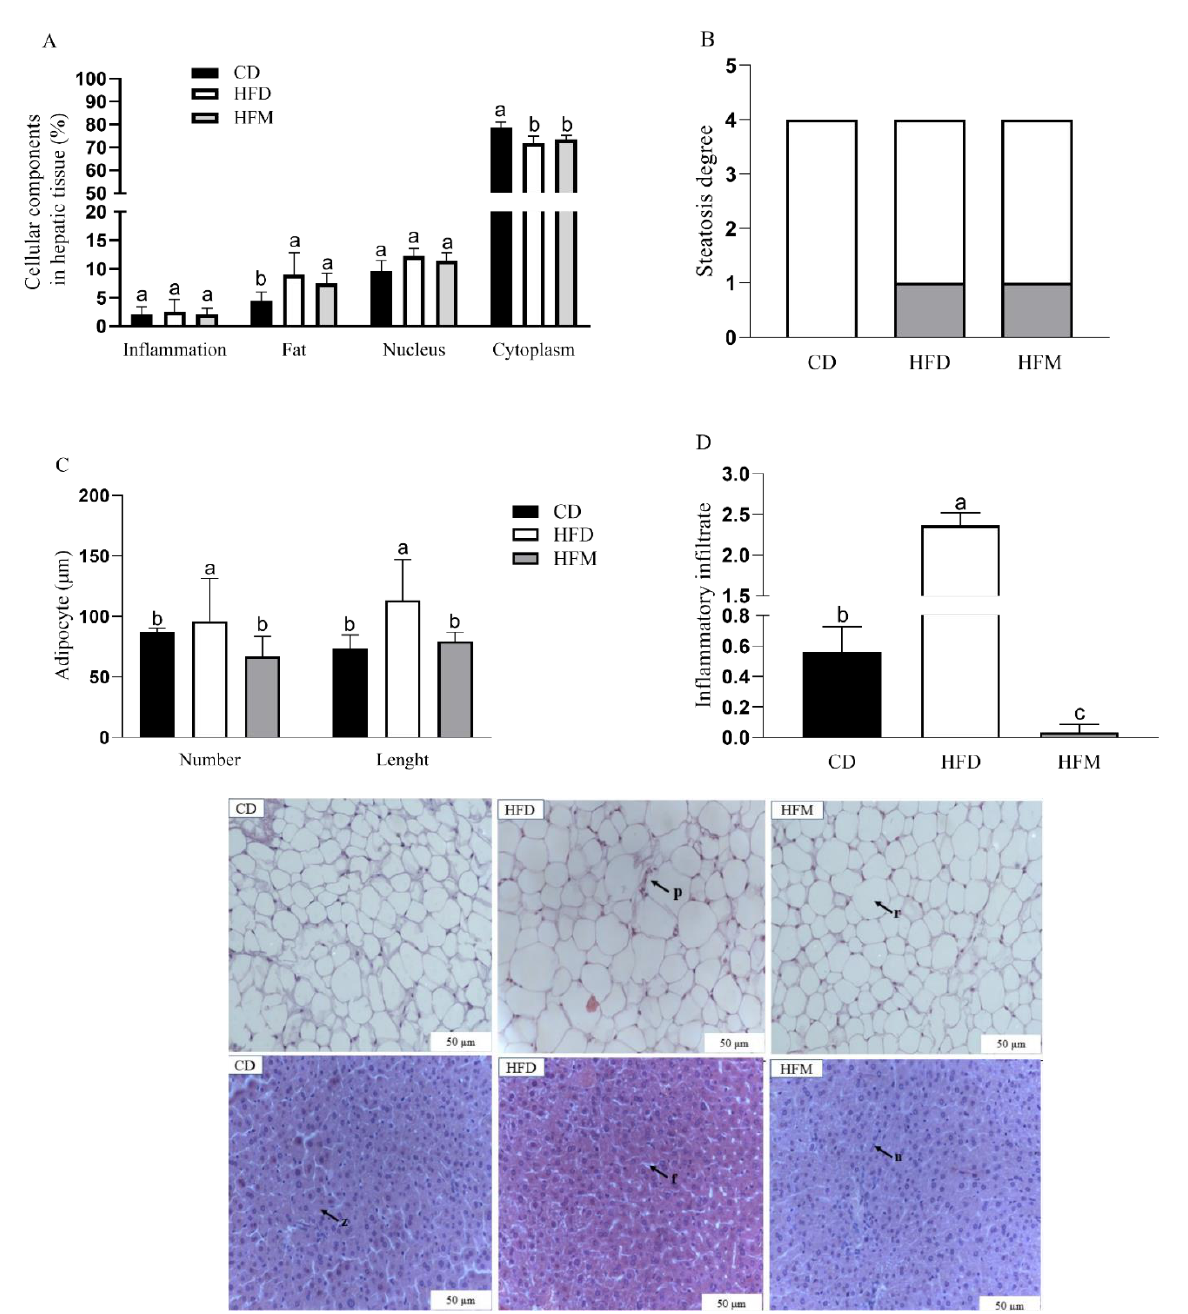
Figure 4. Cellular components: percentage in hepatic tissue ( A ), steatosis degree ( B ), number and length of adipocyte ( C ), and inflammatory infiltrate ( D ). The black arrows represent the following: z: cytoplasm, f: fat vesicles, n: nucleus, p: inflammatory infiltrate, and r: adiposity. Data are expressed as mean ± standard deviation (n = 10). Different letters indicate a statistical difference based on the Newman – Keuls test ( p ≤ 0.05). CD: control diet; HFD: high-fat diet; HFM: high-fat diet with macauba pulp oil.